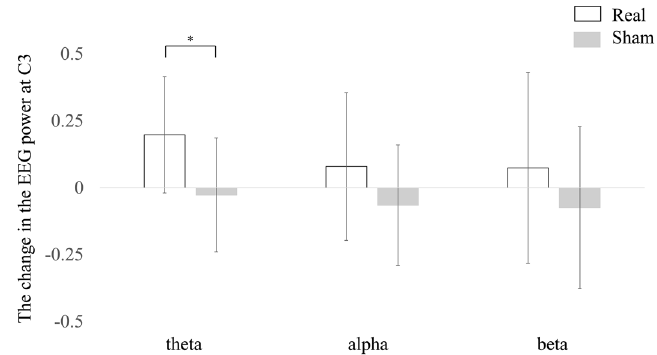
Figure 3. The changes in the EEG power for each frequency band at C3 averaged across all the subjects for the real and sham tSMS. Error bars indicate standard deviation. The change was significant only for the theta band (*).